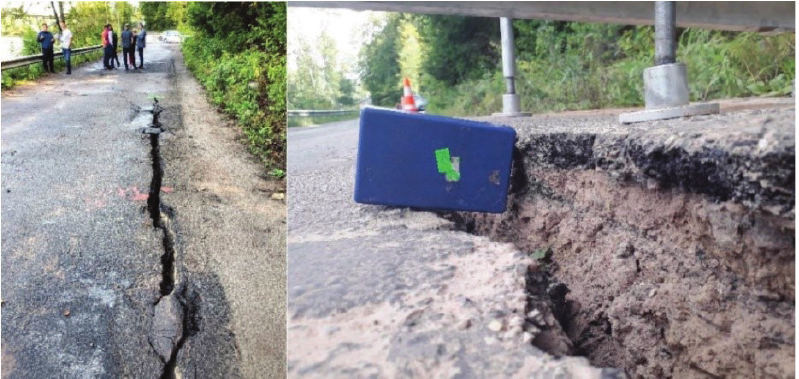
Figure 3. Deformations on existing